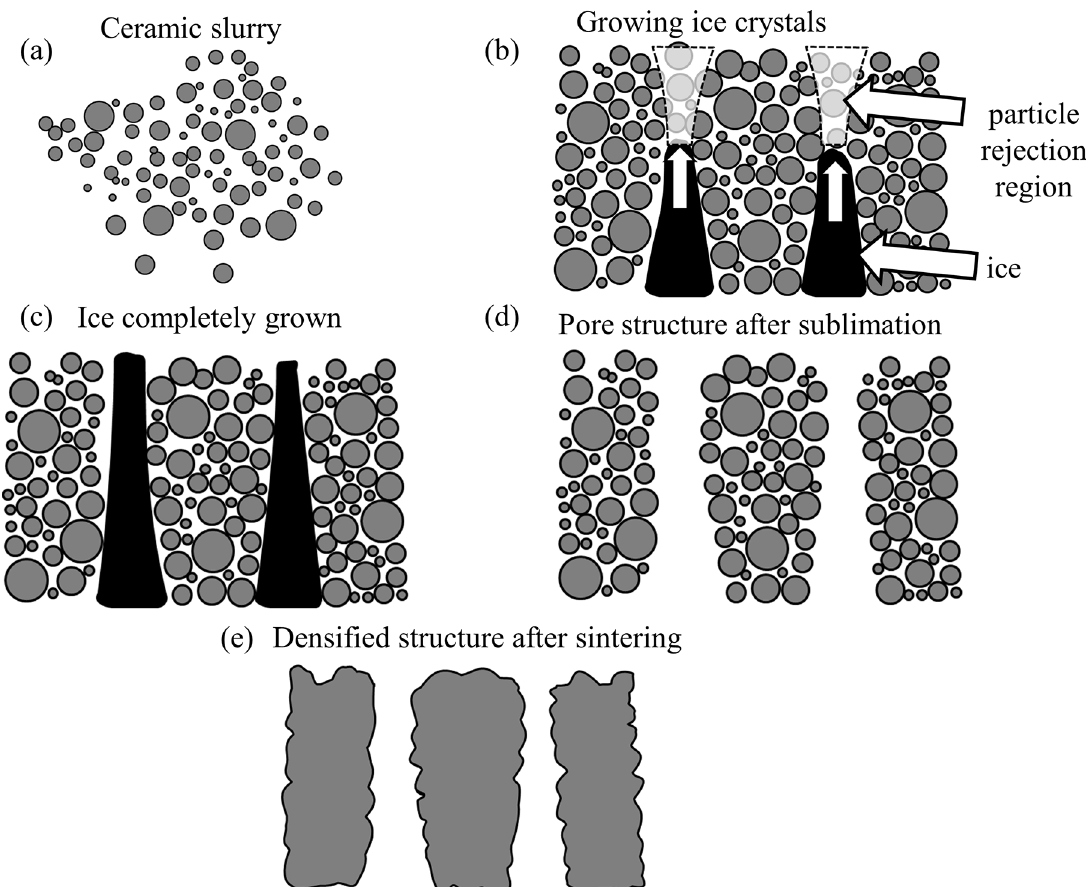
Figure 1. Schematic illustration of the freeze-casting process followed by the heat treatment for production of ceramic substrates (Adapted from 13